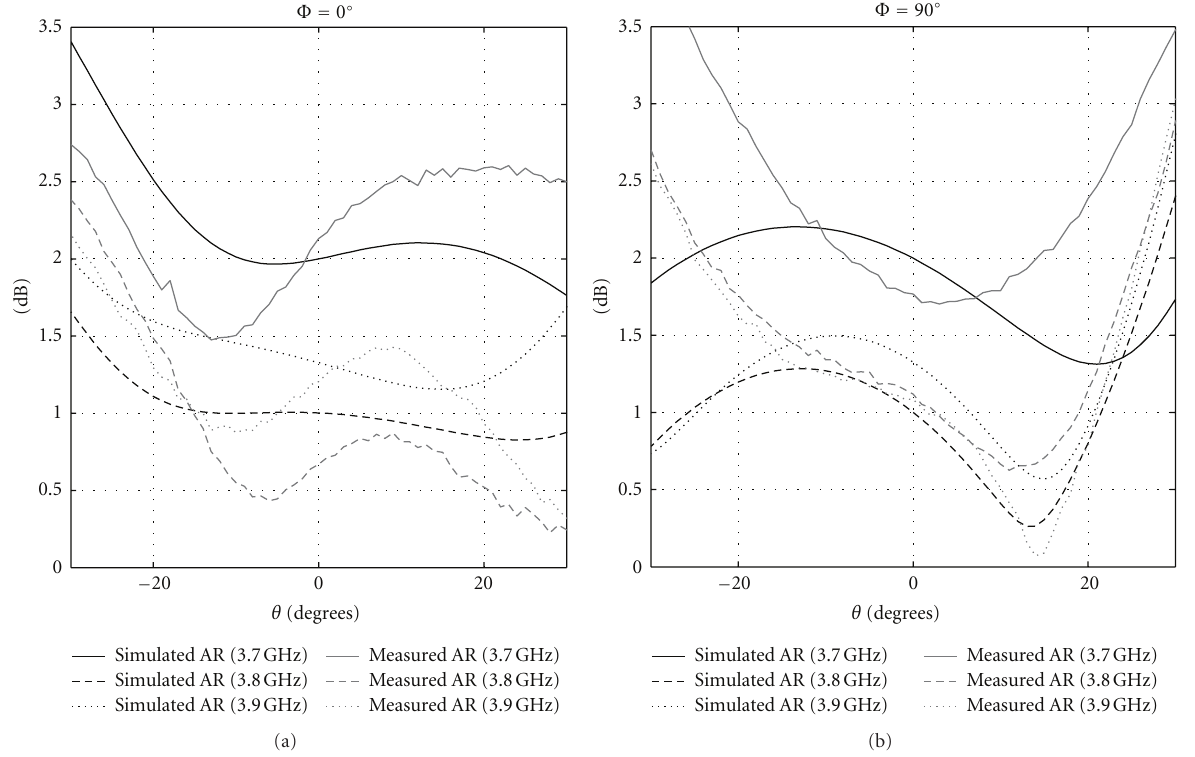
Figure 11: Simulated and measured axial ratio (AR) obtained over the angular aperture in the two principal Φ planes (0 ◦ at left and 90 ◦ at